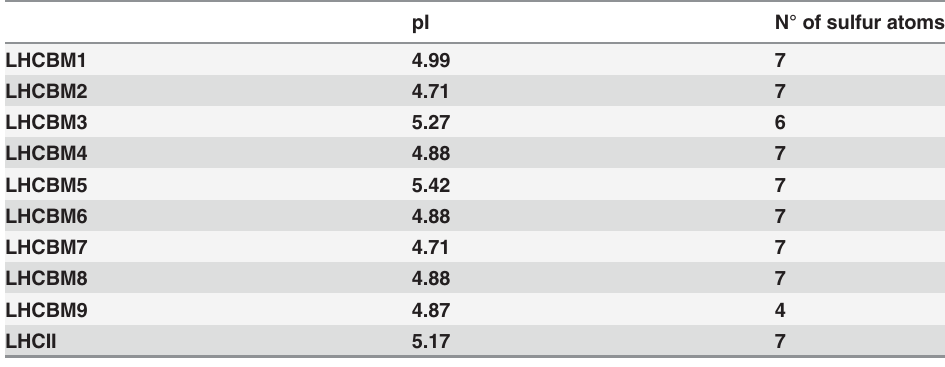
Table 1. Isoeletric point and number of sulfur atoms of the LHCBM proteins.